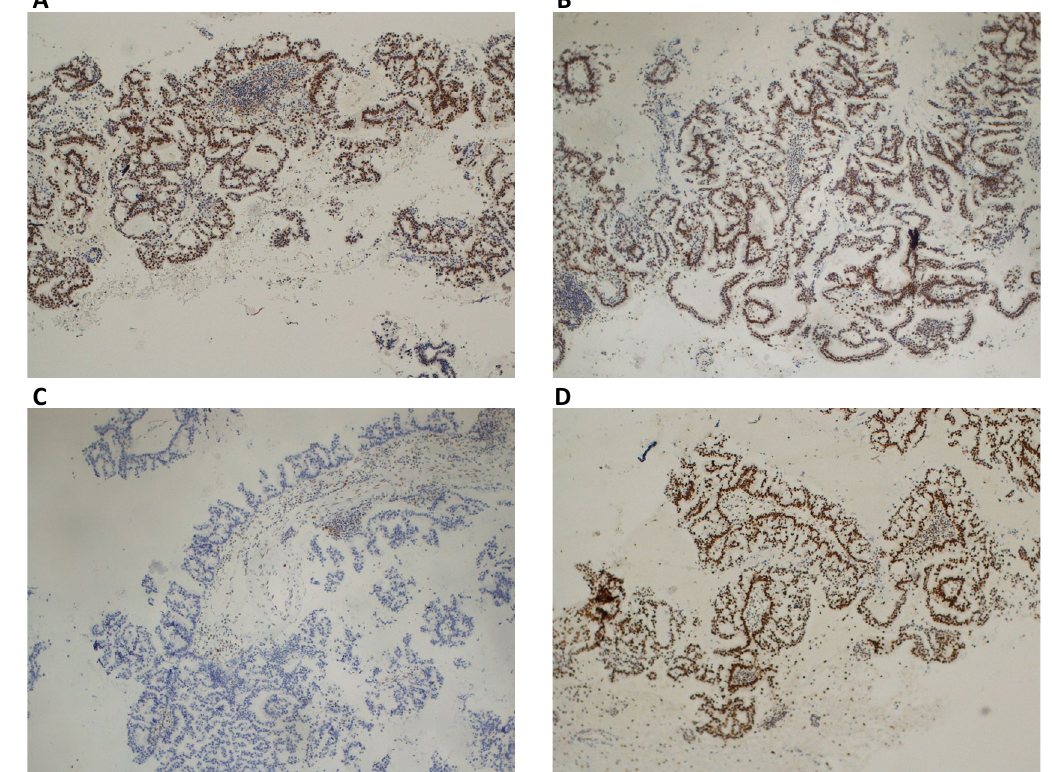
Figure 2. Immunohistochemical staining of MMR proteins evaluated on lung cancer. (A) Normal nuclear expression of MLH1 protein; (B) normal nuclear expression of MSH2 protein; (C) lack of expression of MSH6 protein; (D) normal nuclear expression of PMS2 protein. Magnification